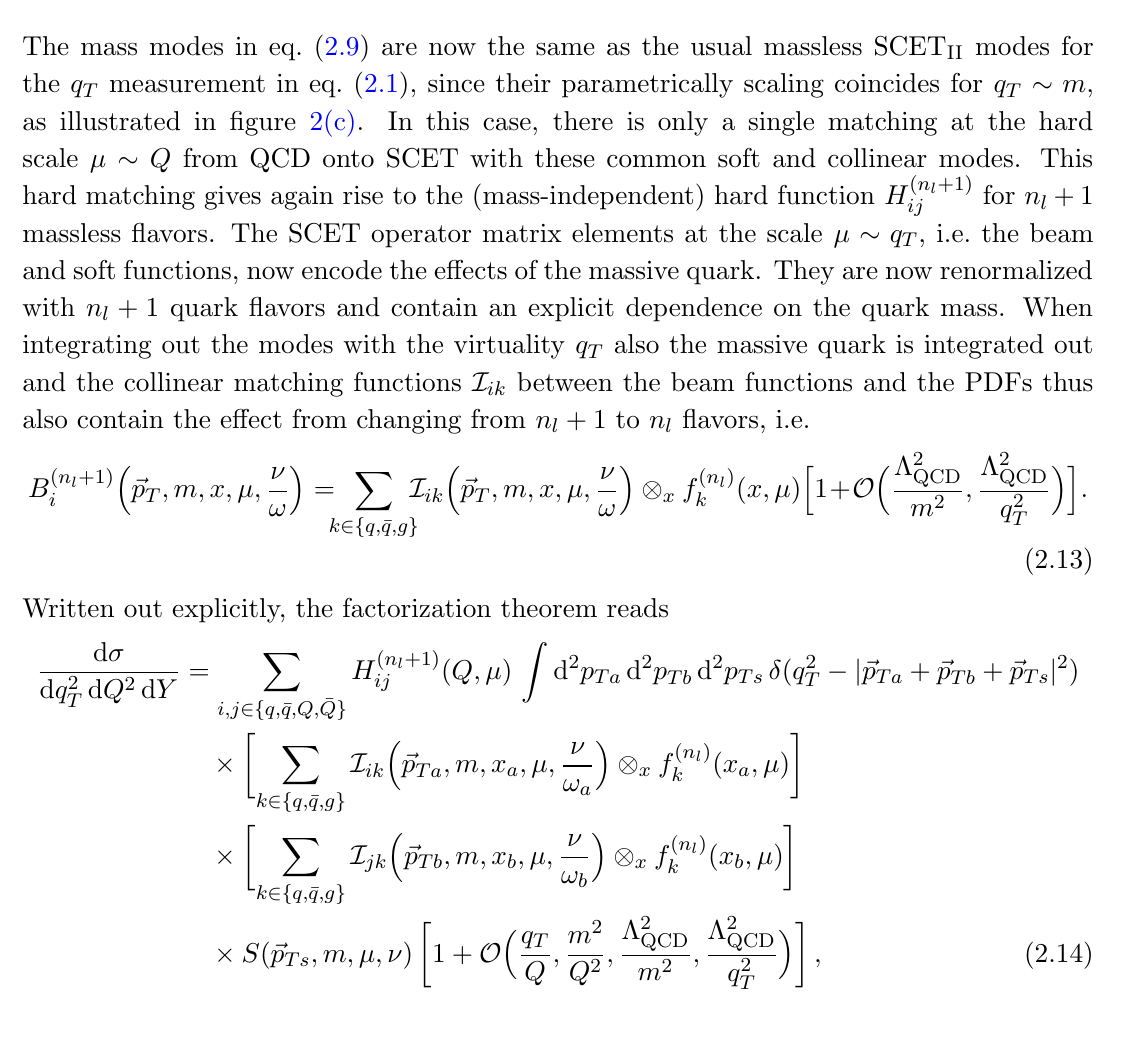
Figure 3 . Illustration of the renormalization group evolution for q T of the hard, beam, soft, and parton distribution functions in invariant mass and rapidity. The anomalous dimensions for each evolution step involve the displayed number of active quark (cid:13)avors. The label m indicates that the corresponding evolution is mass